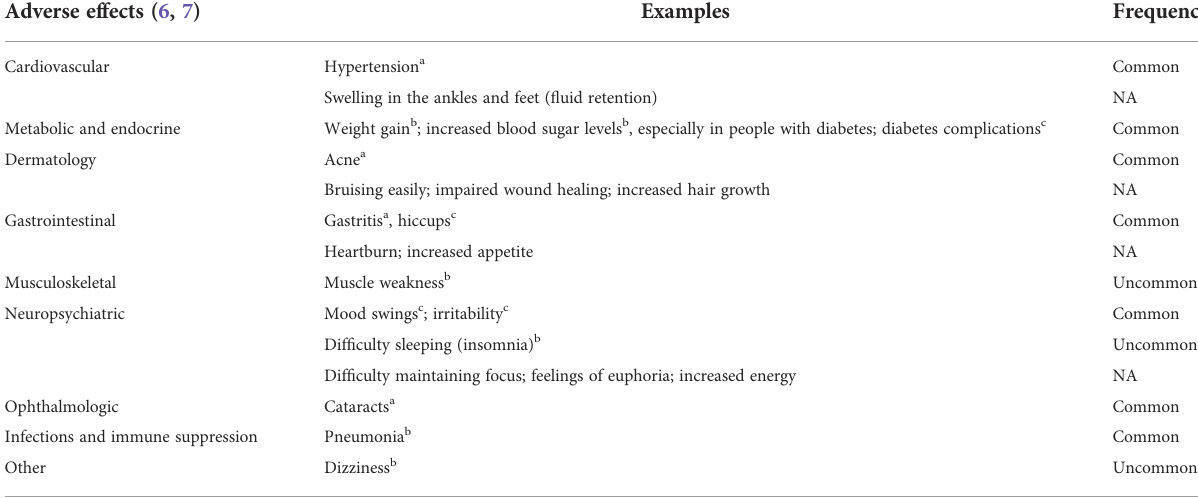
TABLE 1 Possible AEs associated with corticosteroid dexamethasone treatments. Adverse effects (6,